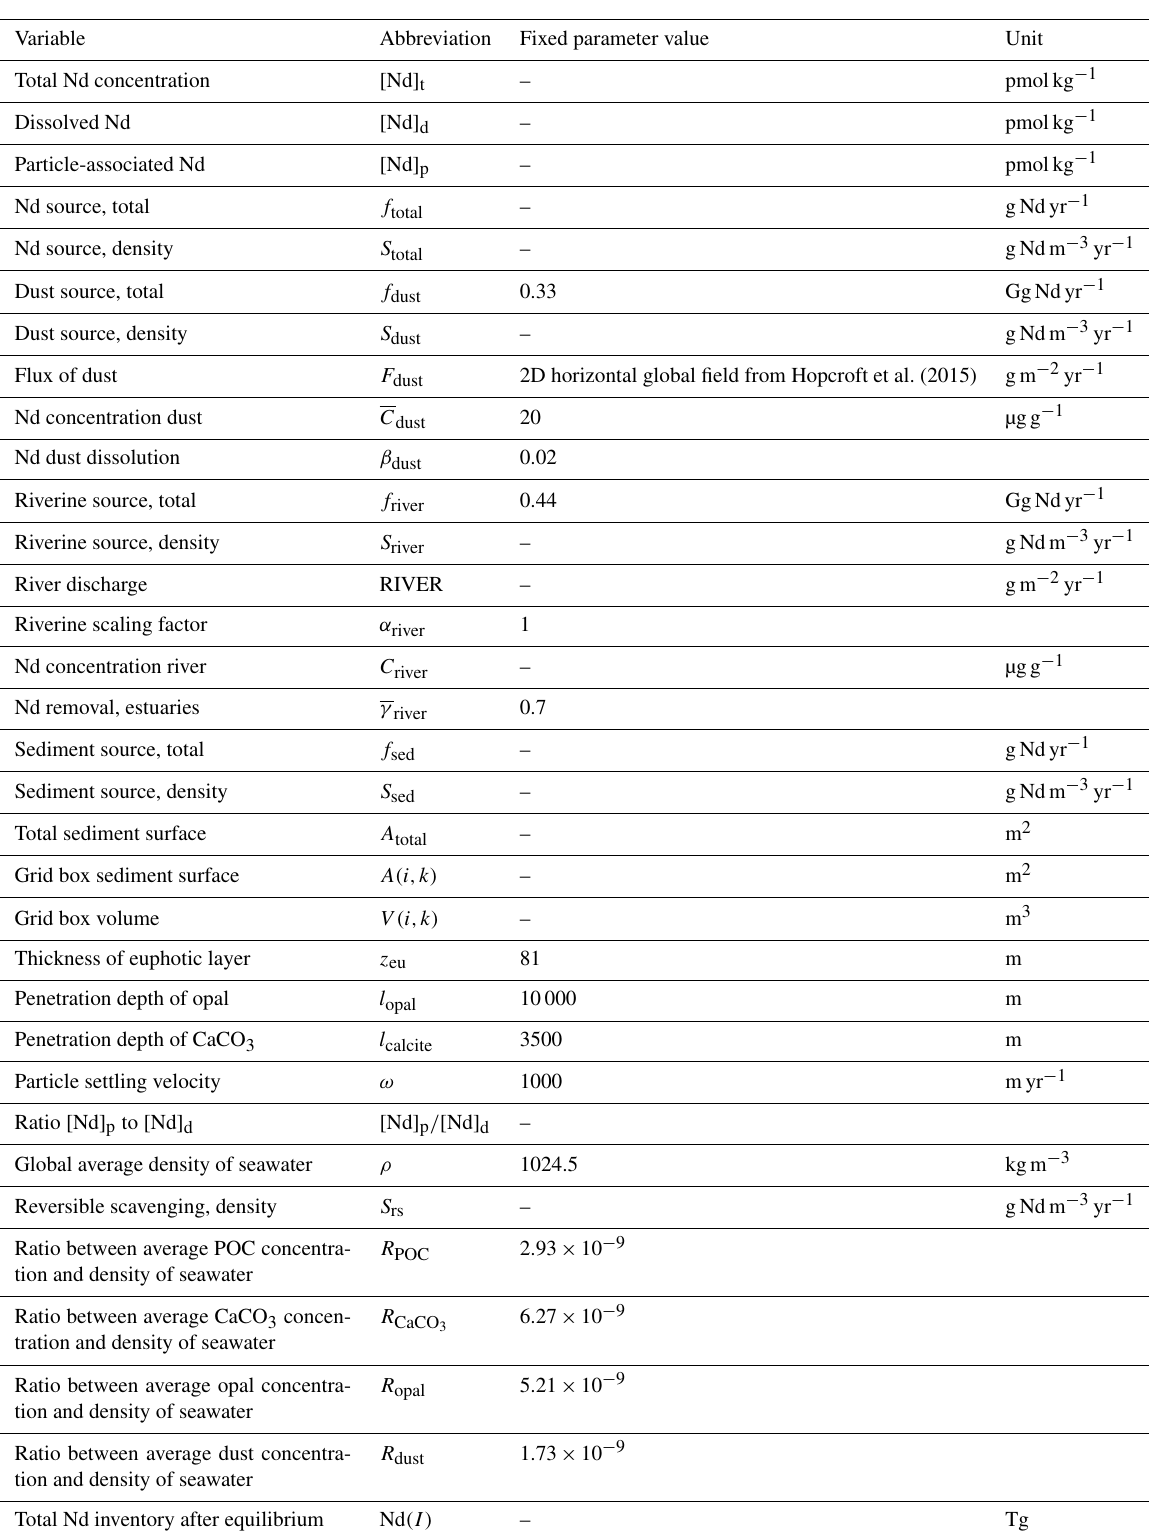
Table 1. Nd scheme model parameters, abbreviations, fixed model parameter values, and